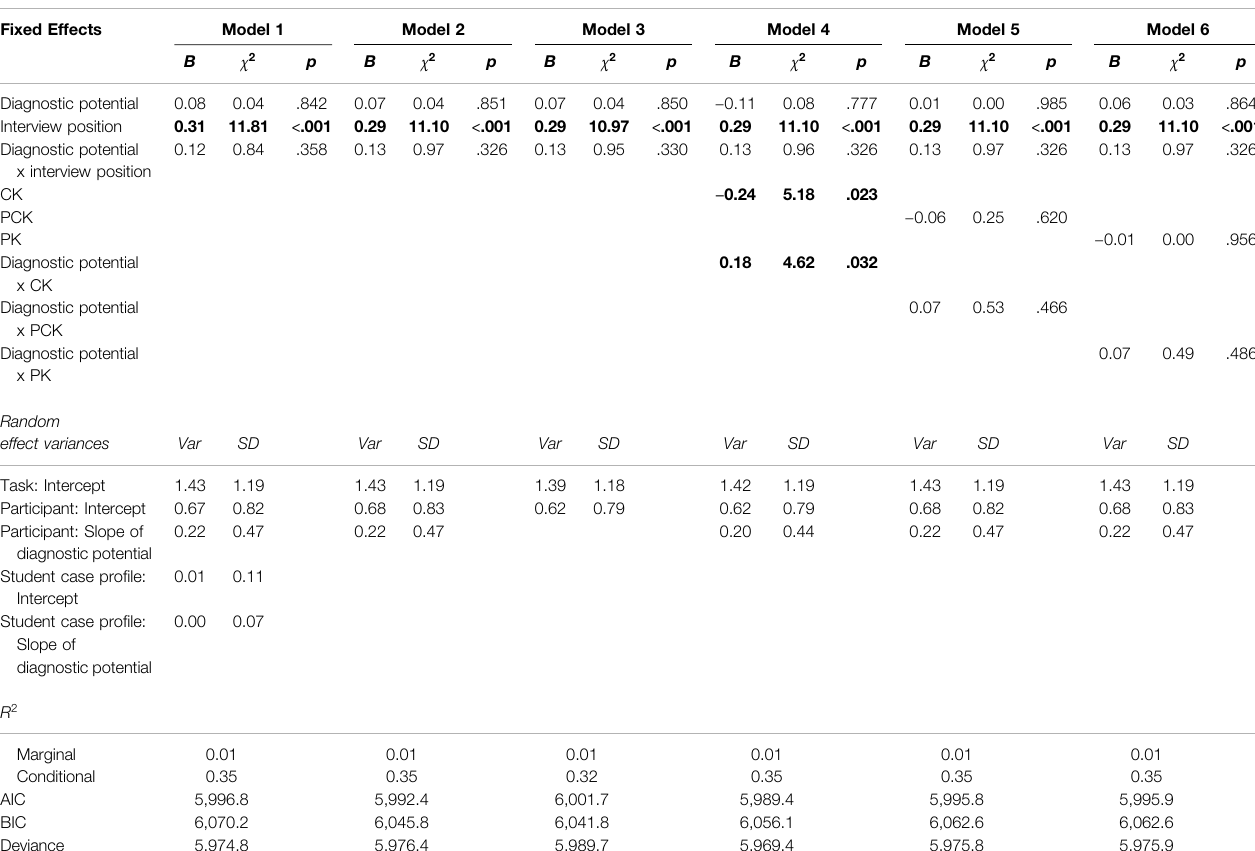
TABLE 4 | Different GLMM for analyzing the sensitivity to the diagnostic task potential. Fixed